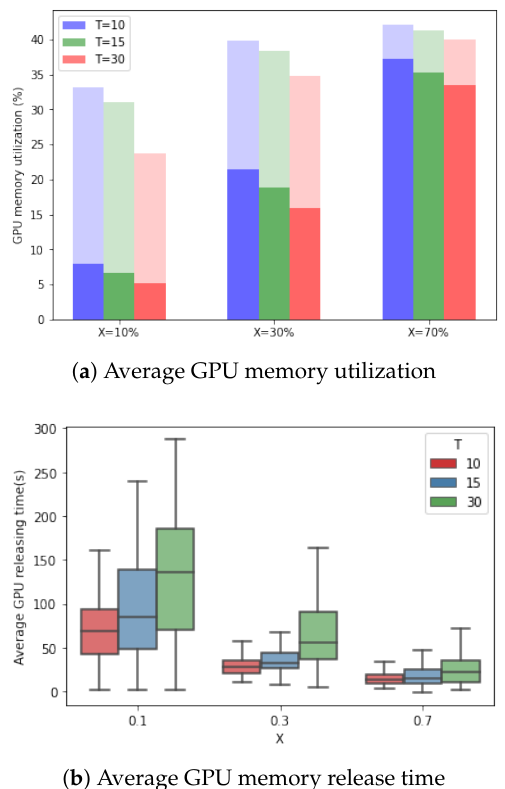
Figure 11. Average GPU memory utilization and average GPU memory release time with respect to T and X on the Baseline and proposed AdaMM without frame differencing. Average GPU memory utilization of the proposed framework (dark shading) and additional GPU memory utilization of Baseline (light